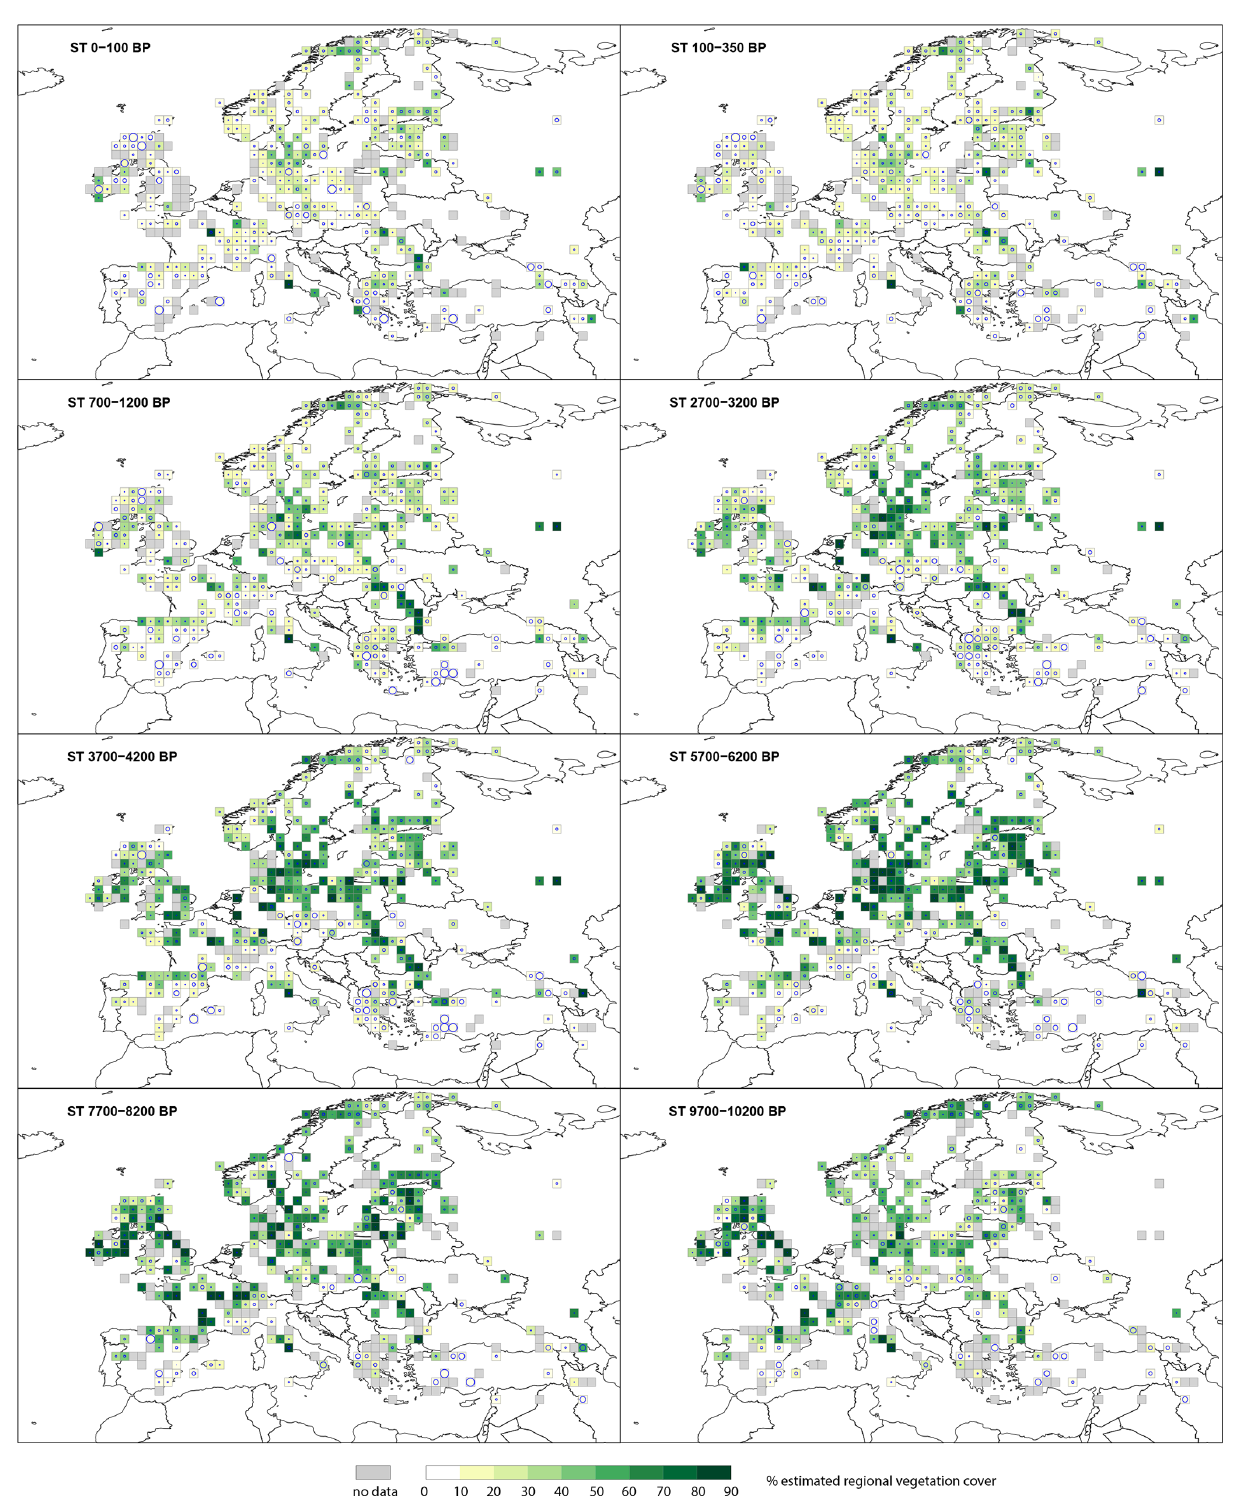
Figure 4. Grid-based REVEALS estimates of summer-green tree (ST) cover for eight Holocene time windows. Percentage cover of STs in 10% intervals represented by increasingly darker shades of green from 20%. Grey cells: cells without pollen data for the time window but with pollen data in other time windows. Circles in grid cells represent the coefficient of variation (CV; the standard error divided by the REVEALS estimate). When SE ≥ REVEALS estimate, the circle fills the entire grid cell, and the REVEALS estimate is not different from zero. This occurs mainly where REVEALS estimates are